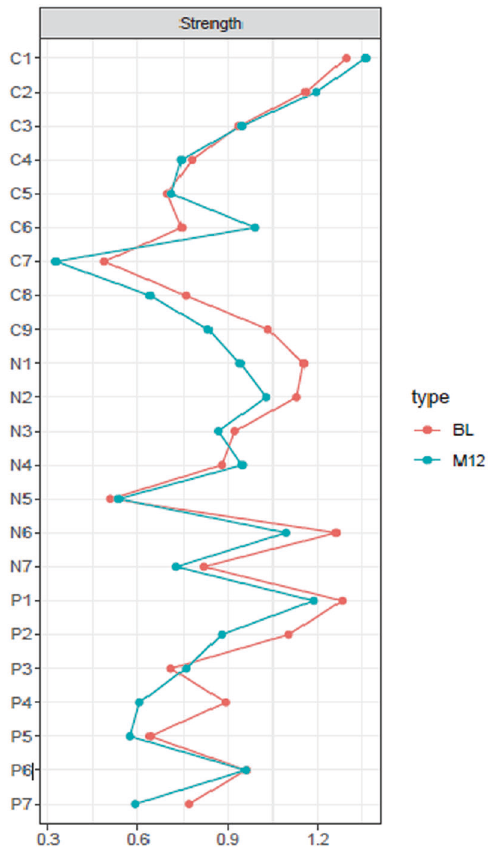
Fig. 2 Node Strength centrality estimates for the baseline and 12- month networks. Red lines = baseline network; blue lines = 12- month network. Standardized z-scores are plotted for ease of interpretation. Higher scores represent higher centrality estimates (i.e. the symptom has greater in fl uence in the